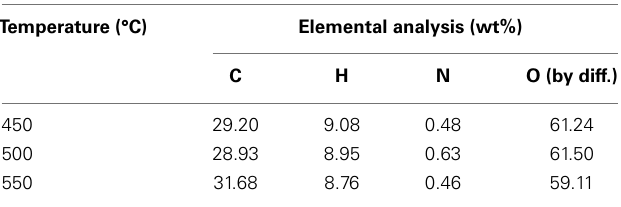
Table 2 | Elemental analyses of bio-oils from bagasse pyrolysis under conventional heating